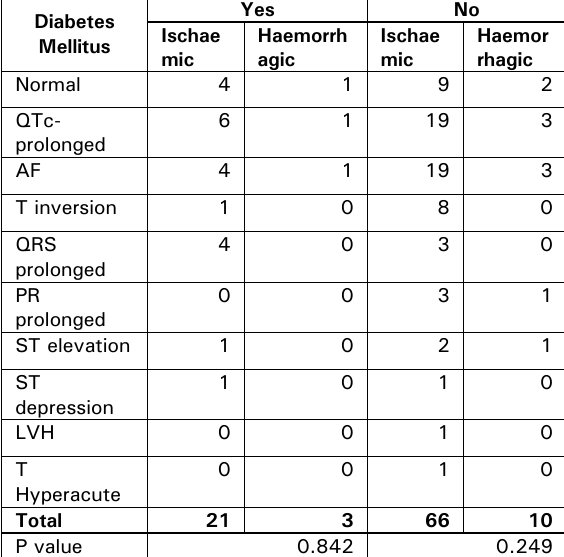
Table 5: Comparison of ECG changes in Ischaemic and Haemorrhagic Stroke in patients with and without